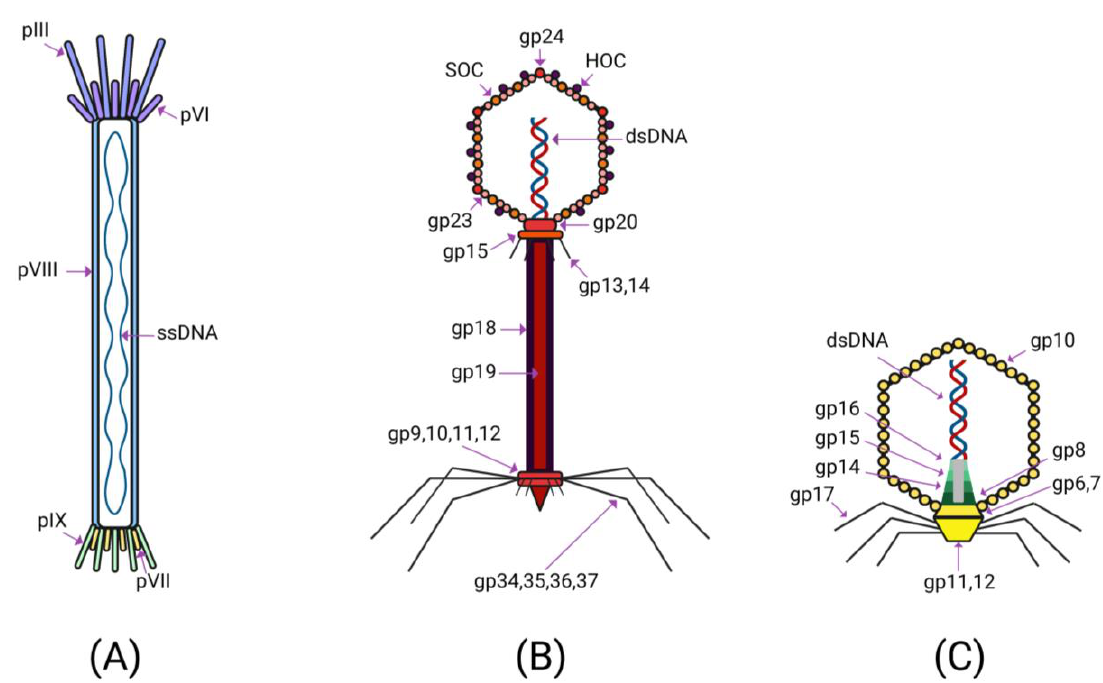
Figure 1. The structures of ( A ) M13 phage, ( B ) T4 phage and ( C ) T7 phage.